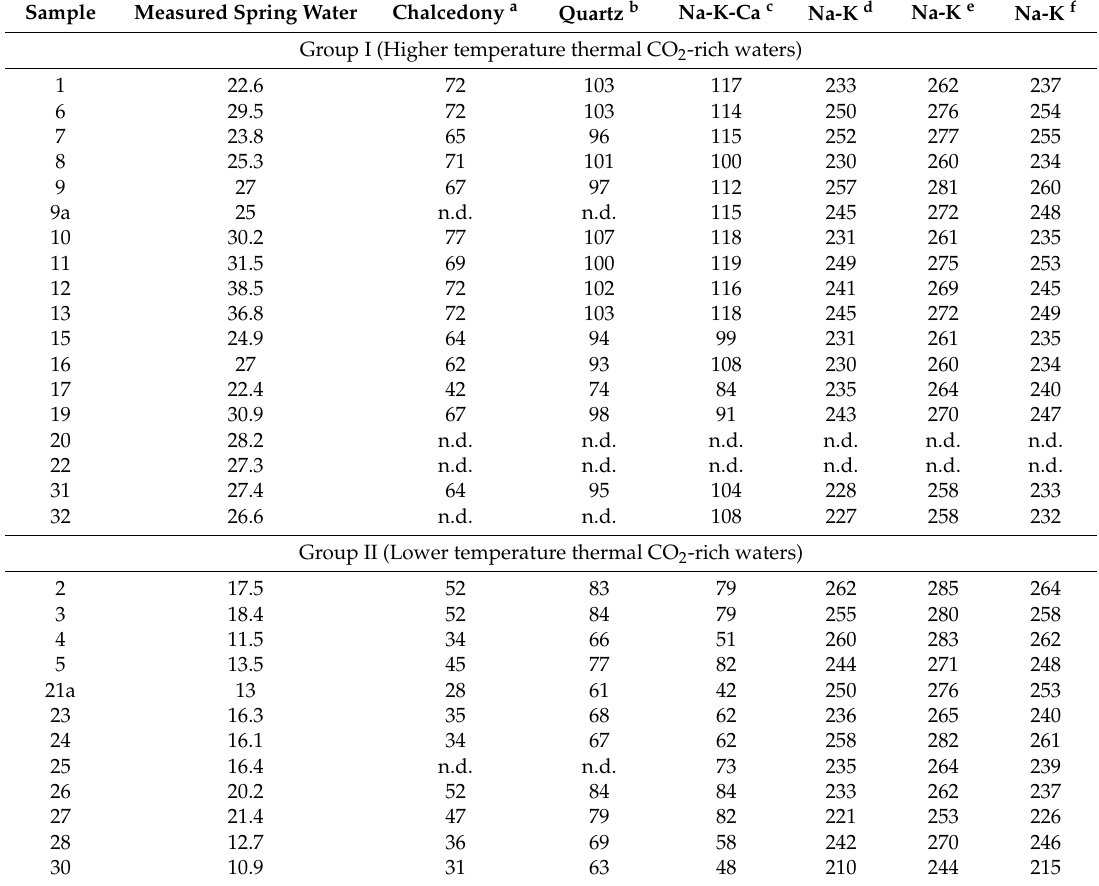
Figure 7. Giggenbach (Na–K–Mg 1/2 ) diagram [46] of the Choygan spring waters composition. Symbols are the same as for Figure 3. Table 2. Geothermometry results for the Choygan spring waters (°C) (n.d. indicates no data). Sample